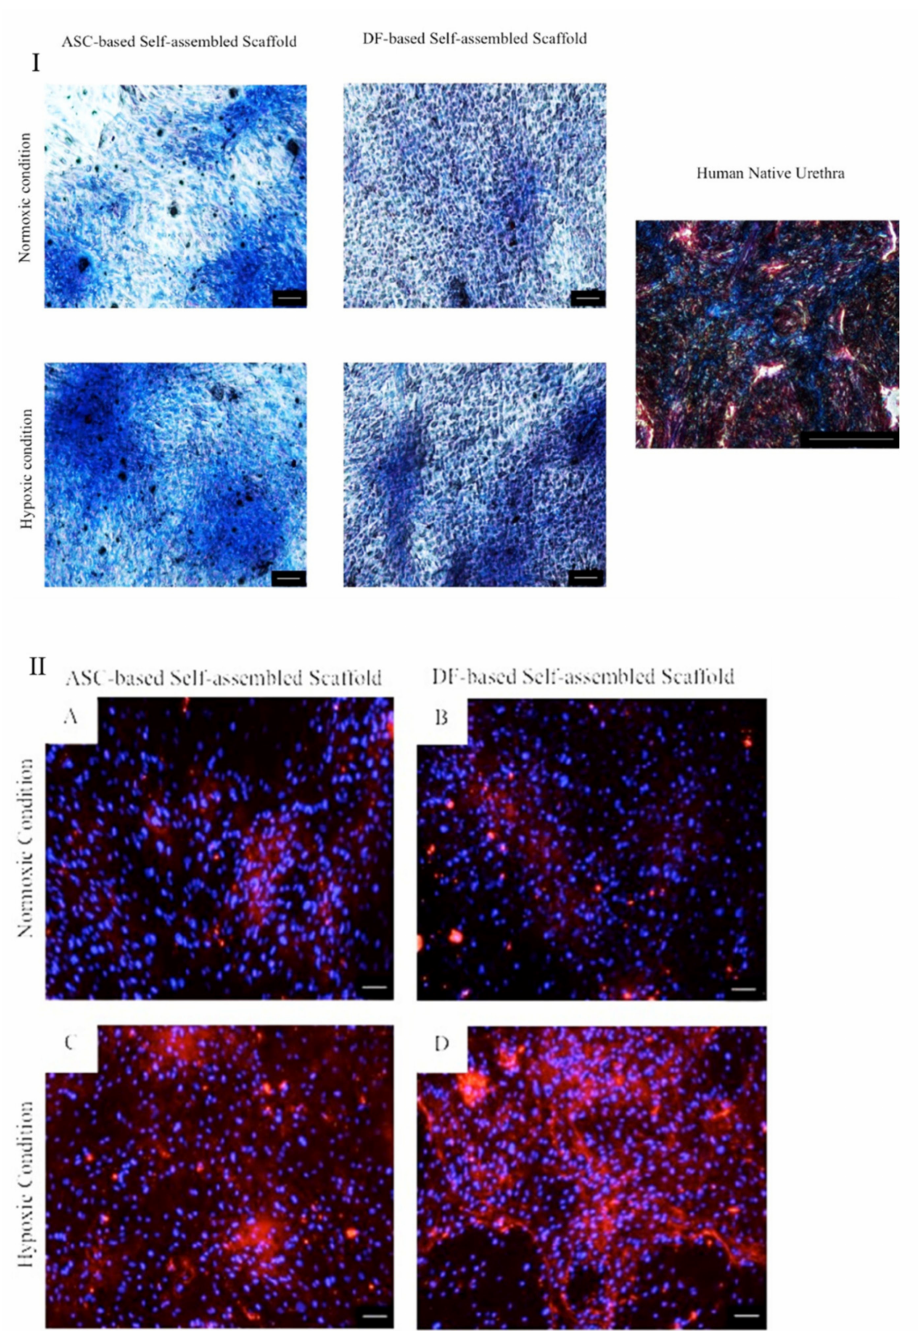
Figure 7. ( I ) Masson’s trichrome staining of ASC-based self-assembled scaffold in which the expres- sion of collagen is detected in blue color. DF-based self-assembled scaffold was used as comparative control. Human native urethra was used as positive control. ( II ) Immunocytochemical staining of ASC-based self-assembled scaffold with anticollagen type I antibody in which the expression of collagen type I, is detected in red color ( A , C ). DF-based self-assembled scaffold was used as comparative control ( B , D ). 4’,6-diamidino-2-phenylindole (DAPI) was used as nuclear counterstain in blue color in all samples. The scale bar represents 100 µ m. Results are from a representative of three independent